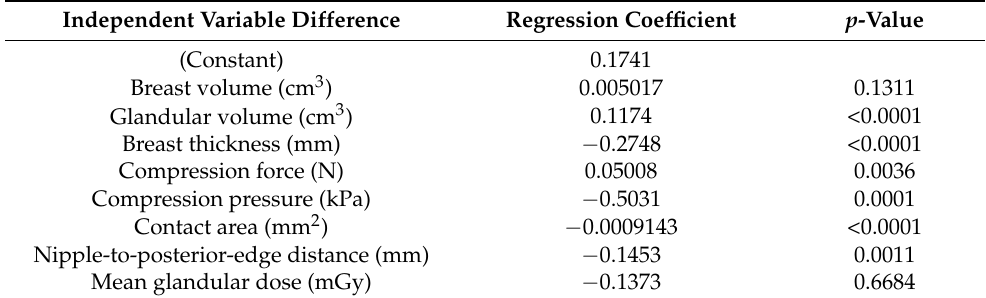
Figure 3. (Upper row) LE-CEM images of a woman with dense breasts. VBD: 20.1%; breast volume: 319 cm 3 ; volume of glandular tissue: 64 cm 3 ; breast thickness: 32 mm; nipple-to-posterior-edge distance: 86 mm. (Lower row) DM images acquired 11.5 months after the CEM exam. VBD: 30.5%; breast volume: 450 cm 3 ; volume of glandular tissue: 136 cm 3 ; breast thickness: 41 mm; nipple-to-posterior-edge distance: 98 mm. Breast positioning was better in the DM exam, including an additional volume of glandular tissue, leading to a significant increment in VBD. Table 3. Coefficients of the regression equation and p -values resulting from the multiple regression